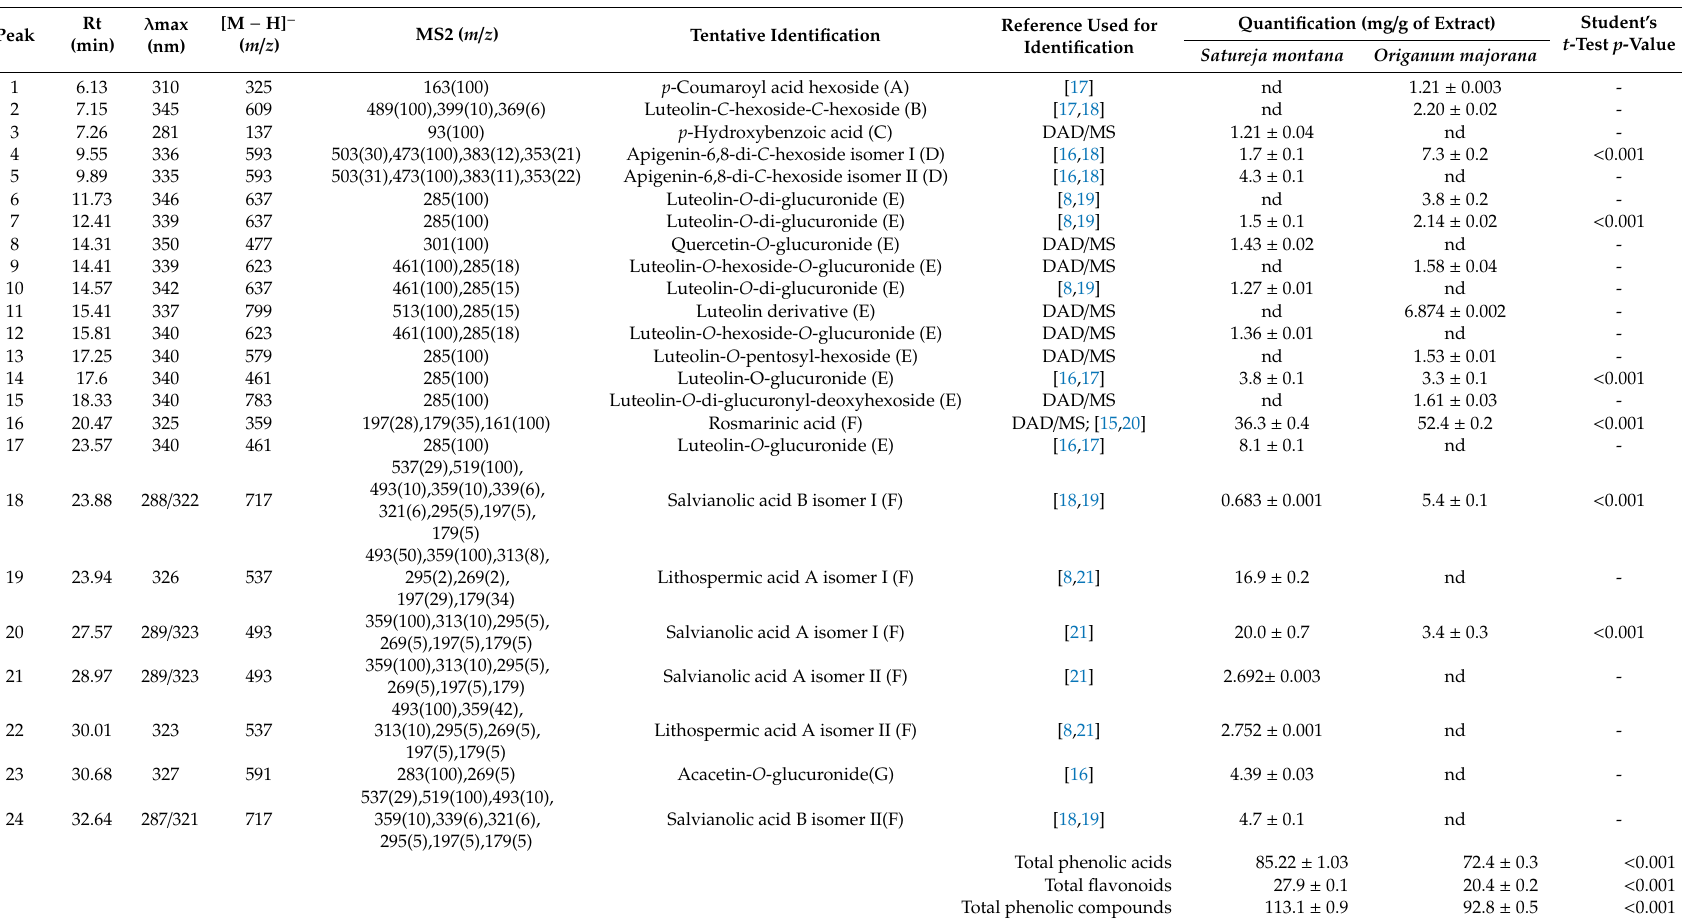
Table 3. Retention time (Rt), wavelengths of maximum absorption in the visible region ( λ max), mass spectral data, tentative identification, and quantification (mg / g of extract) of the phenolic compounds present in Satureja montana and Origanum majorana